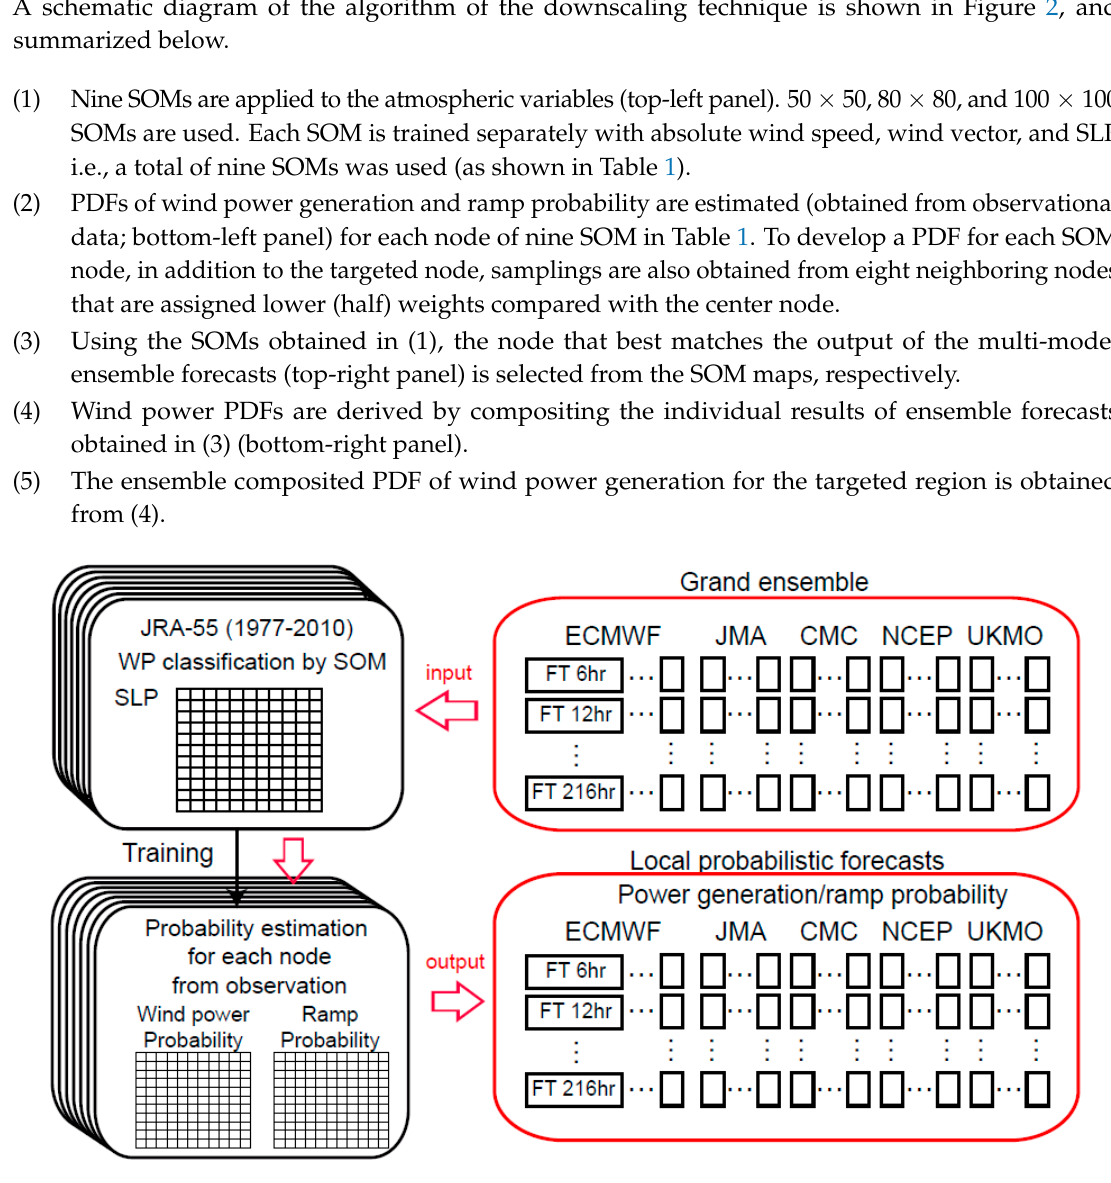
Figure 2. Schematic of the hybrid ensemble using the self-organizing maps (SOMs) technique. The multiple SOM classifications of weather patterns (WPs) are based on the three atmospheric variables during 1977–2011 ( top , left ). Based on the SOM lattices, the PDF (probability density function) of wind power generation and ramp probability are estimated for each node ( bottom , left ). By using the SOM lattice, the forecasted wind power generation and variation are obtained ( bottom , right ) from the 168 members of the multi-center ensemble forecasts ( top , right ).